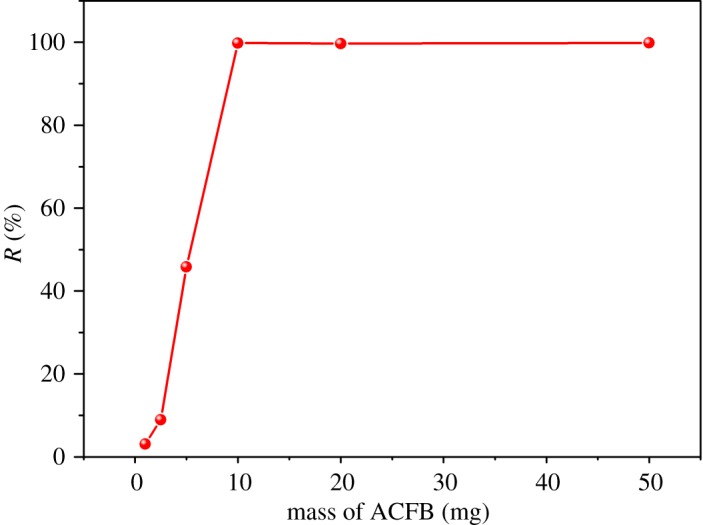
Effect of the AC doses on the removal of MB (C0 = 20 mg l−1, t = 180 min, T = 30°C, pH = 7, v = 100 ml).